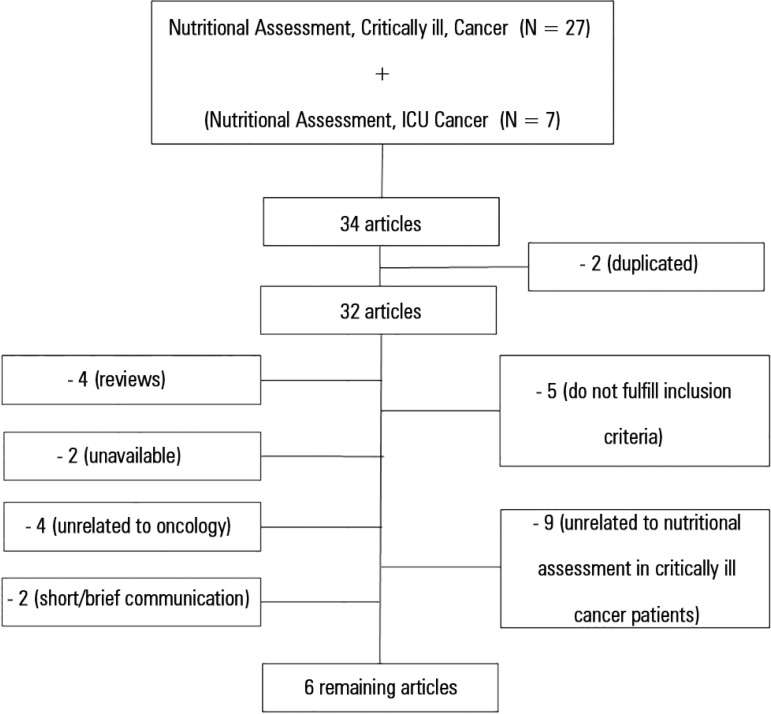
Schematic drawing of the methodology applied.